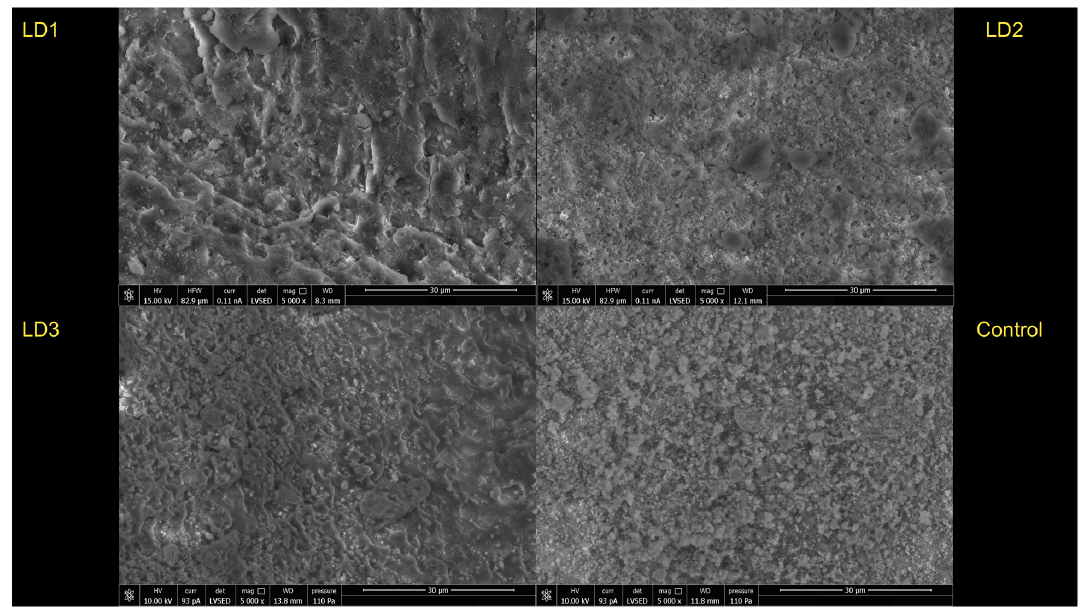
Figure 3. SEM analyses of lithium disilicate crowns. SEM of the cameo surface of lithium disilicate at the 1st (LD1), 2nd (LD2), 3rd (LD3), and a control of a higher laser setting based on a previous proposed protocol [22]. Appl. Sci. 2020 , 10 , x FOR PEER REVIEW